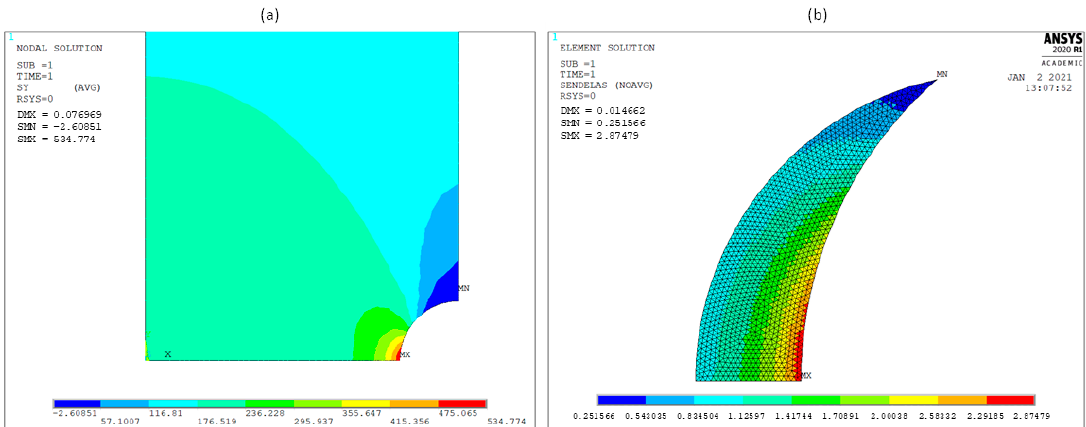
Figure 8. Finite element results. ( a ) Normal stress along the y -direction. ( b ) Elastic strain energy in the control volume.